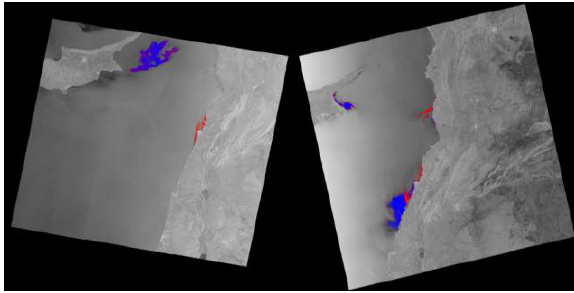
Figure 7. Result with semi-automatic approach (Red: oil, Blue: look-alike) (left) 2006/08/03, (right)